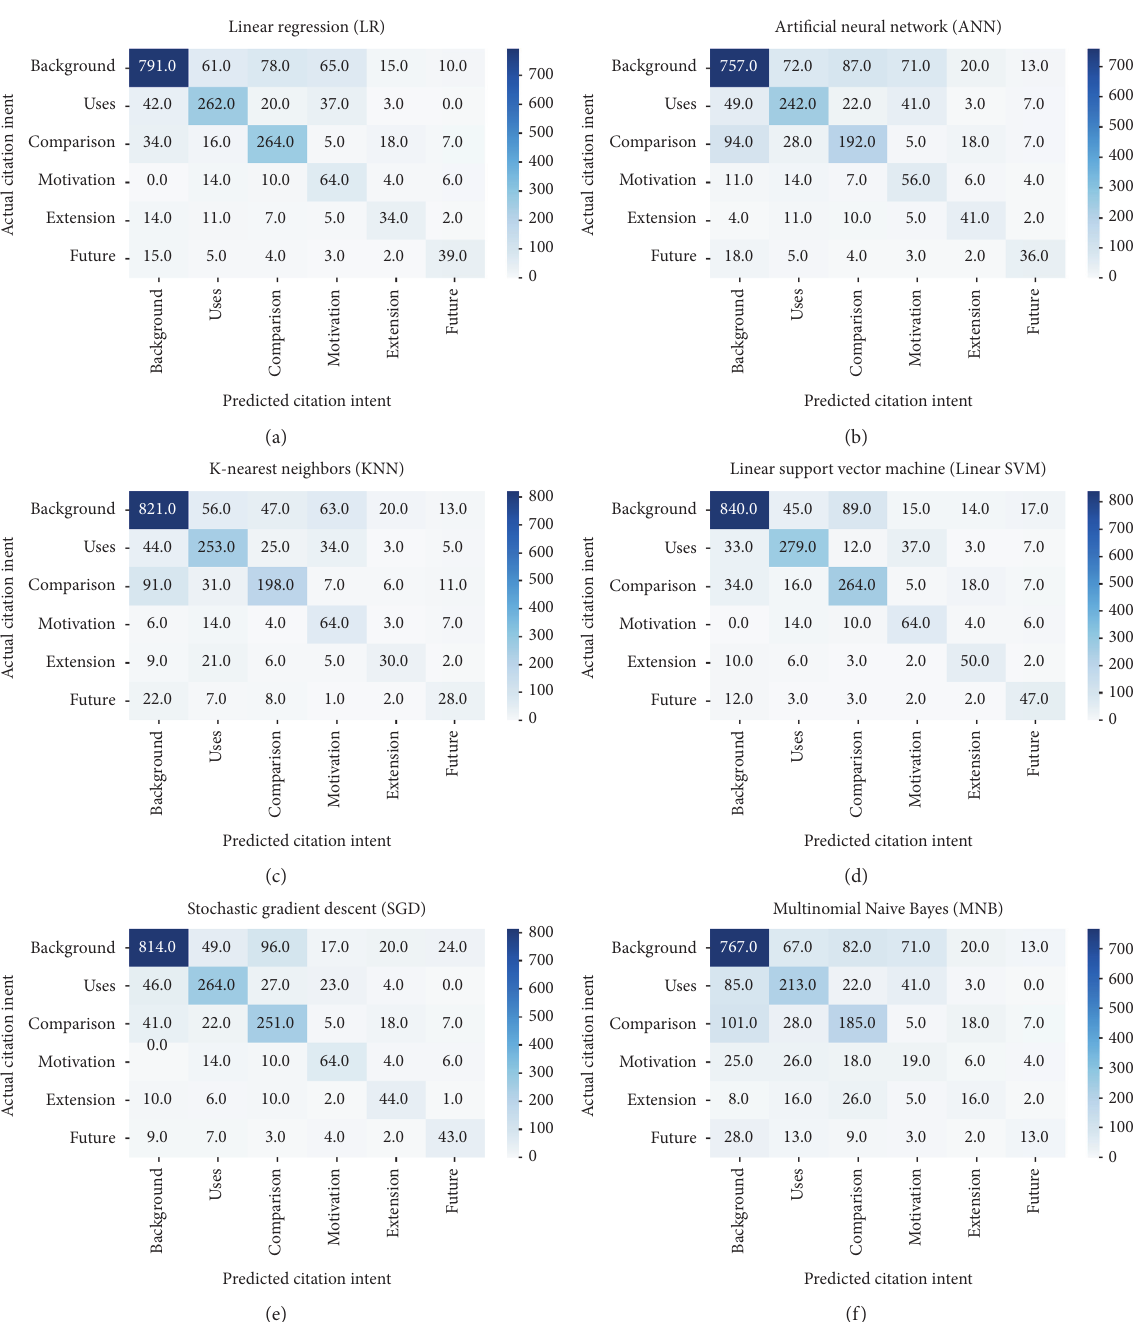
Figure 4: Multiclass confusion matrix using the ACL-ARC dataset for each